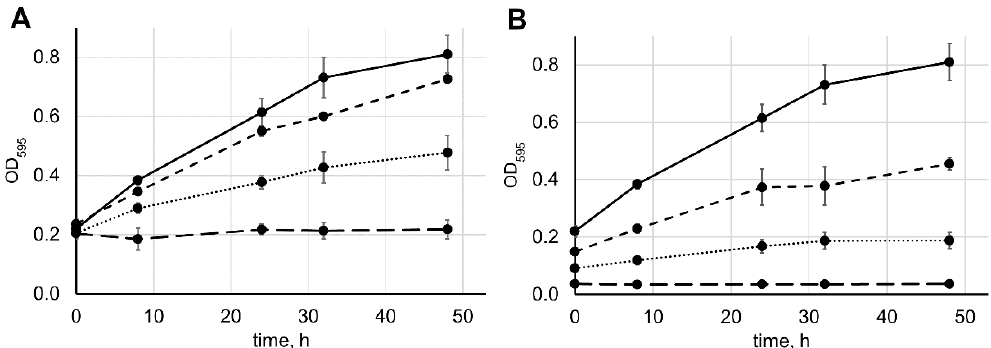
Figure 2. The dependence of pentaglycine cleavage rate on the concentrations of lysostaphin and pentaglycine. ( A ) We mixed 4 mM pentaglycine in 20 mM HEPES, pH 7.5, with 1 µ M (dotted line), 3 µ M (dashed line), or 5 µ M (solid line) lysostaphin, or without lysostaphin (long-dash line); incubated the mixture at 37 ◦ C for 0–48 h; and reacted the mixture with ninhydrin. Average results from six (5 µ M lysostaphin, same as in Figure 1A), three (1 and 3 µ M lysostaphin), or two (without lysostaphin, same as in Figure 1A) independent experiments are shown; error bars represent standard deviation. ( B ) We mixed 2 mM (dotted line), 3 mM (dashed line), 4 mM (solid line), or 0 mM (long-dash line) pentaglycine in 20 mM HEPES, pH 7.5, with 5 µ M lysostaphin; incubated the mixture at 37 ◦ C for 0–48 h; and reacted the mixture with ninhydrin. Average results from six (4 mM pentaglycine, same as in Figure 1A), three (2 and 3 mM pentaglycine), or one (without pentaglycine) independent experiments are shown; error bars represent standard deviation.